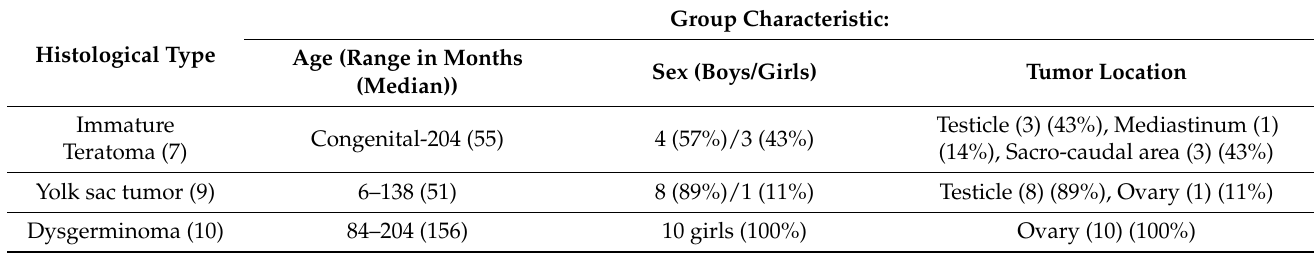
Table 2. Patho-clinical characteristics of germ cell